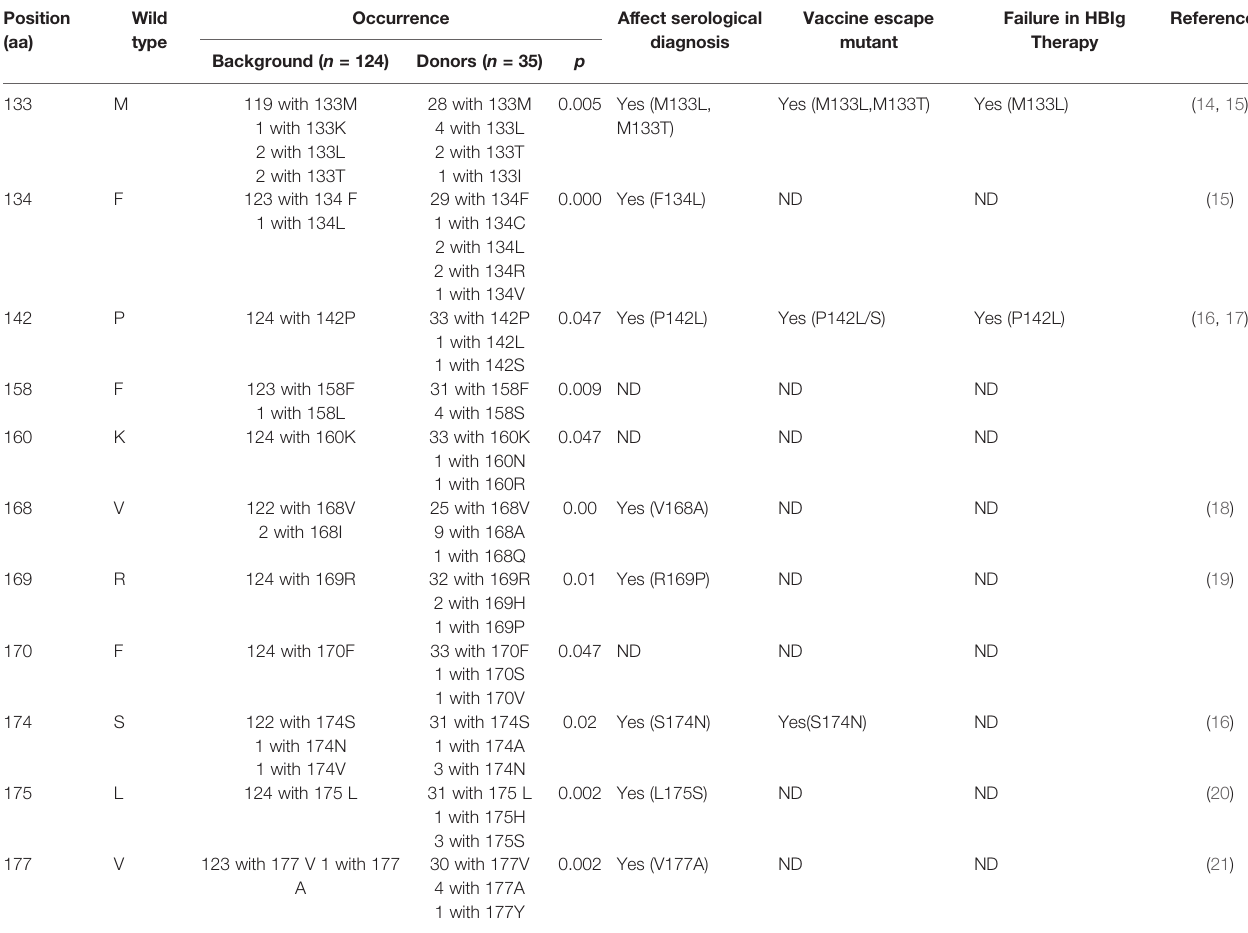
TABLE 2 | Notable mutations in the MHR and out of the MHR of genotype B in local donors with